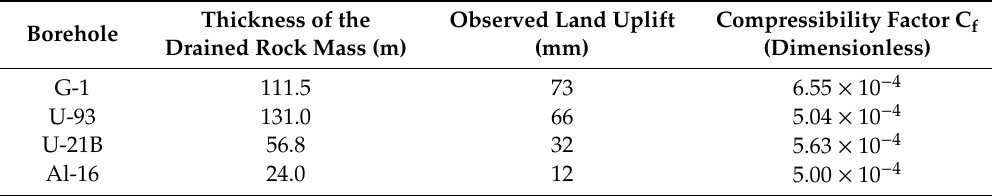
Table 2. Determination of the compression coe ffi cient C f of rock mass for the Konrad mine area. The thickness of the drained rock mass in particular boreholes was obtained from [32]. Note that there are no additional measurement results available in this area, we, therefore, assume that the uplift value presented was a complete one.